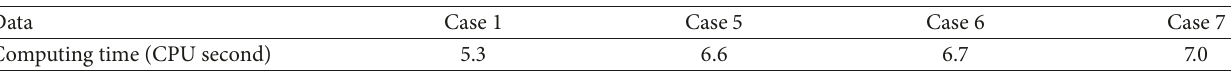
Table 9: Computing time of